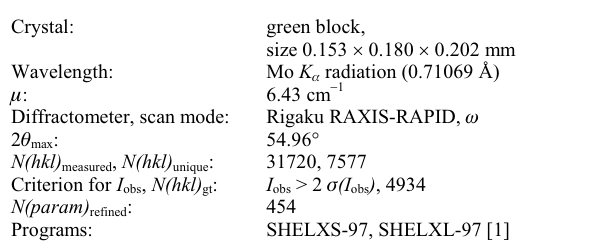
Table 1. Data collection and handling.